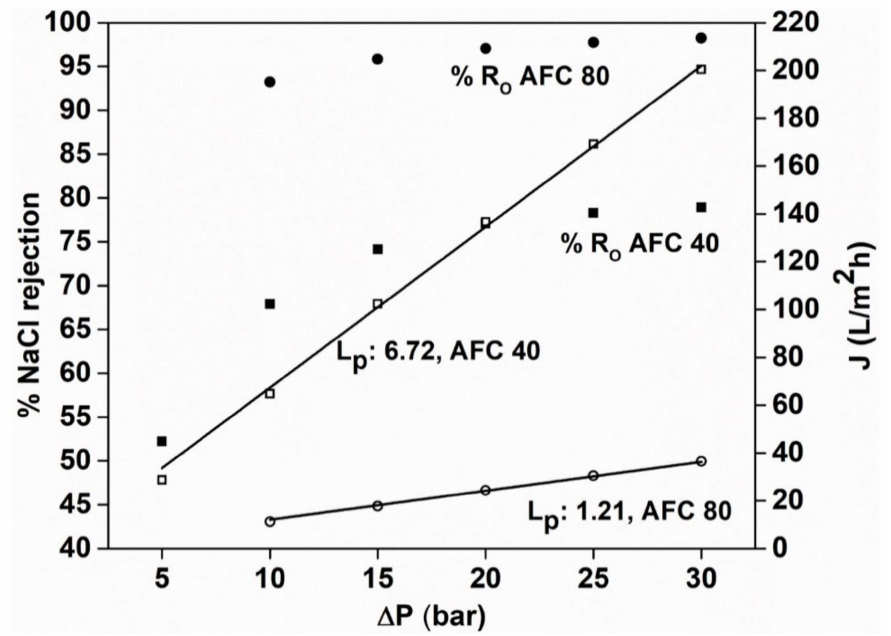
Figure 3. NaCl rejection for the AFC 40 and AFC 80 membranes.